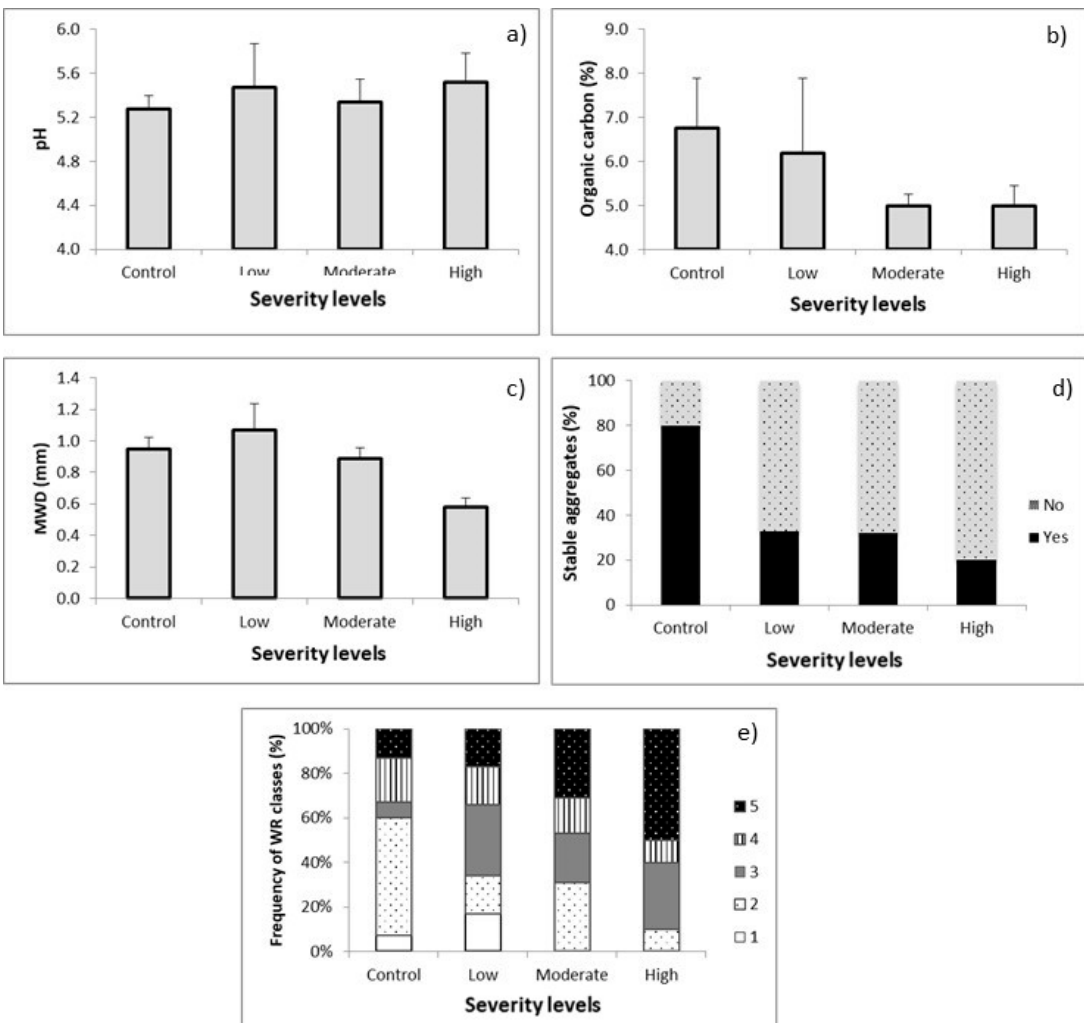
Figure 2. Mean values and standard error for ( a ) pH, ( b ) soil organic carbon, ( c ) mean weight diameter, ( d ) aggregate stability, and ( e ) frequency of water repellency classes (Class 1: Hydrophilic; Class 2: Slight; Class 3: Strong; Class 4: Severe and Class 5: Extreme repellency) of soil samples between 0 and 5 cm deep in different severity levels. Table 3. Average soil aggregate size distribution (%) in relation to soil burn severity levels (control, low, moderate, high).